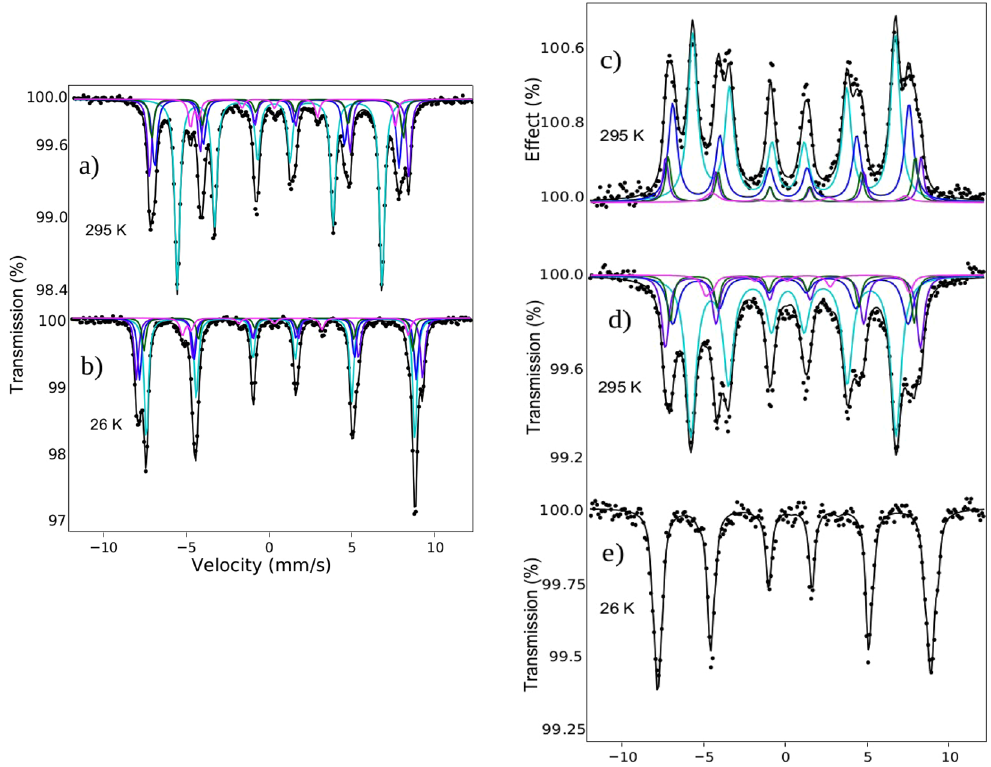
Figure 4. ( a-b ) Mössbauer spectrum of SFO commercial in transmission at 295 K and at 26 K, respectively. ( c – e ) Mössbauer spectrum of the SFO platelets in electron detection mode at 295 K and transmission mode at 295 K and at 26 K, respectively. The five sextets in each spectrum correspond to the sites where the iron cations are positioned.